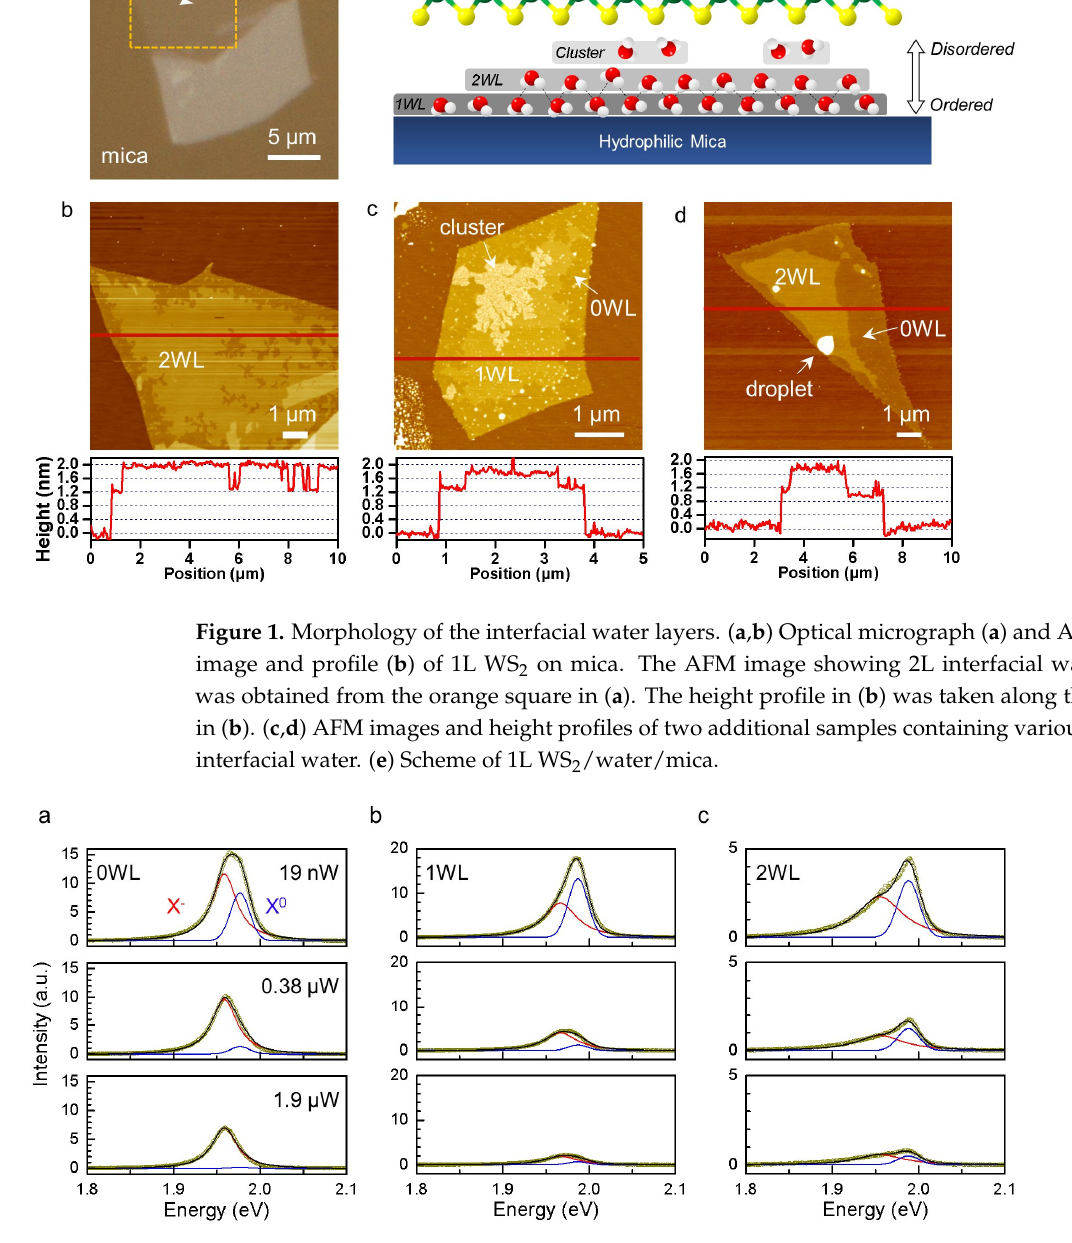
Figure 2. Power-dependent PL spectra of WS 2 /water/mica. ( a – c ) A exciton PL spectra (yellow circles) obtained from water-free ( a ), 1WL ( b ) and 2WL ( c ) areas. For each, the average power (P exc ) of the excitation beam was set to 0.019, 0.38 and 1.9 μ W (from top to bottom). Neutral exciton (X 0 ) and negative trion (X − ) were fitted with a Gaussian (blue) and a Lorentzian (red) function, respectively, resulting in an overall fit (black line).